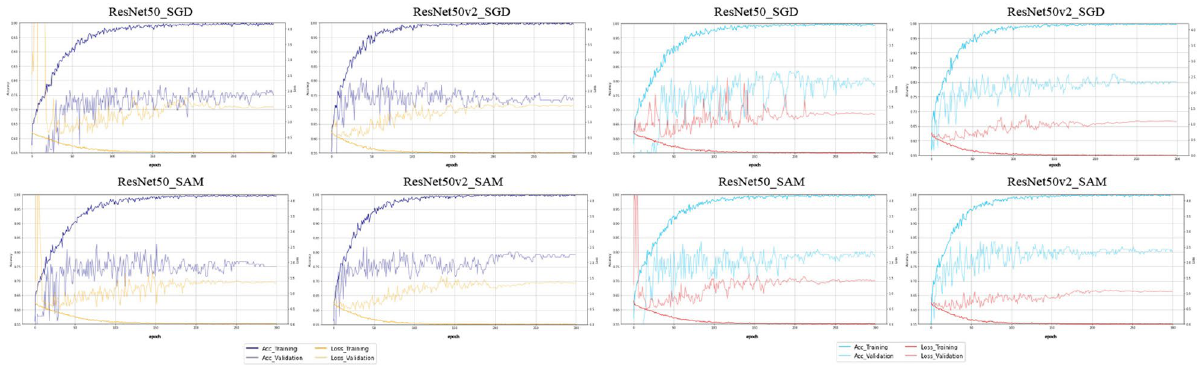
Figure 3. Learning curves for each CNN model in contact and continuity